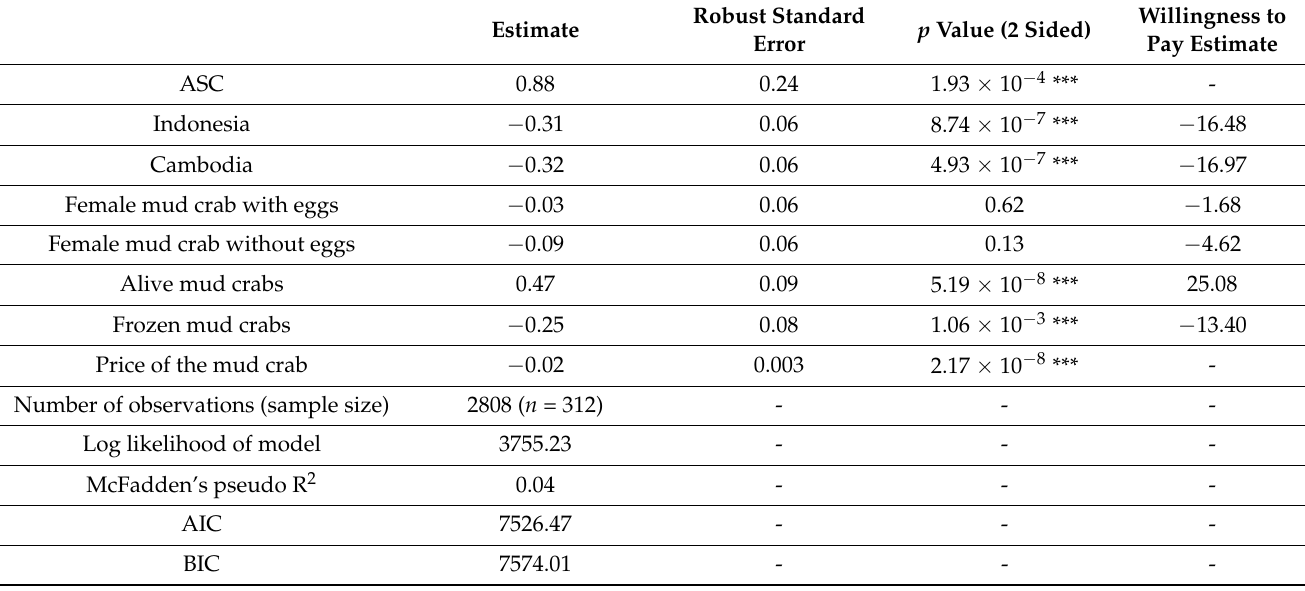
Table 4. Results from conditional logit model and willingness to pay estimate (SGD, Singaporean